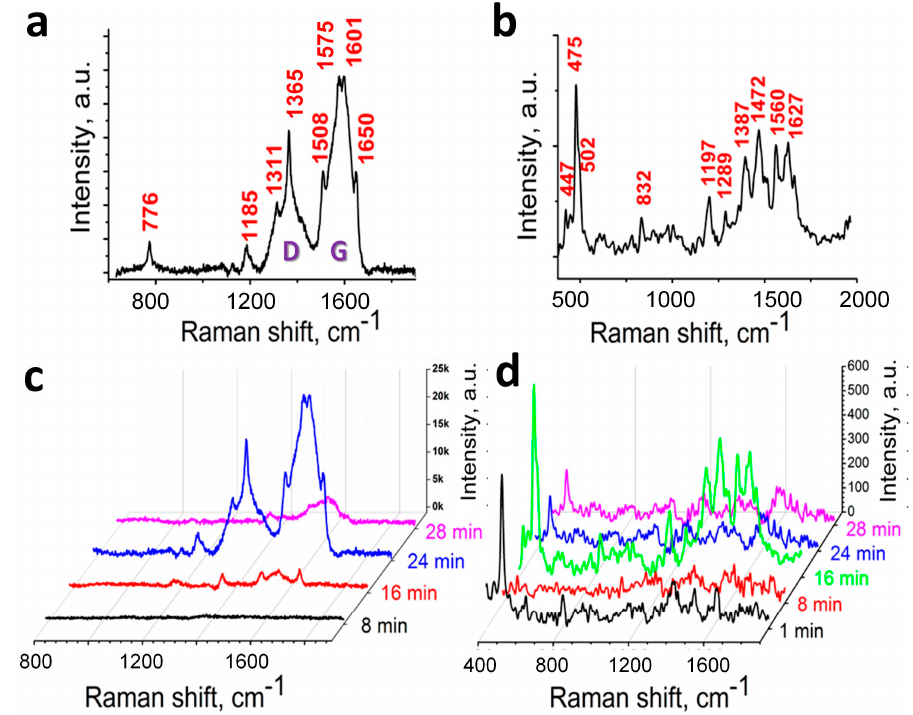
Figure 5. ( a , b ) typical SERS spectra of rhodamine 6G and methylene blue with labeled spectral lines, respectively. Carbon modes D and G at 1360 and 1590 cm − 1 , respectively, are indicated. ( c ) SERS spectra of rhodamine 6G 10 − 7 M (5 μ L aliquot) at the substrates produced on quartz slides via UV-induced photochemical reduction of colorless silver ink for different times of UV illumination (514.4 nm Ar laser, 10% of 20 mW; 100 accumulations). ( d ) SERS spectra of methylene blue 10 − 7 M (5 μ L aliquot) at the substrates produced on quartz slides via UV-induced photochemical reduction of silver citrate complex for different times of UV illumination (632.8 nm He-Ne laser, 0.1% of 17 mW; 100 accumulations).